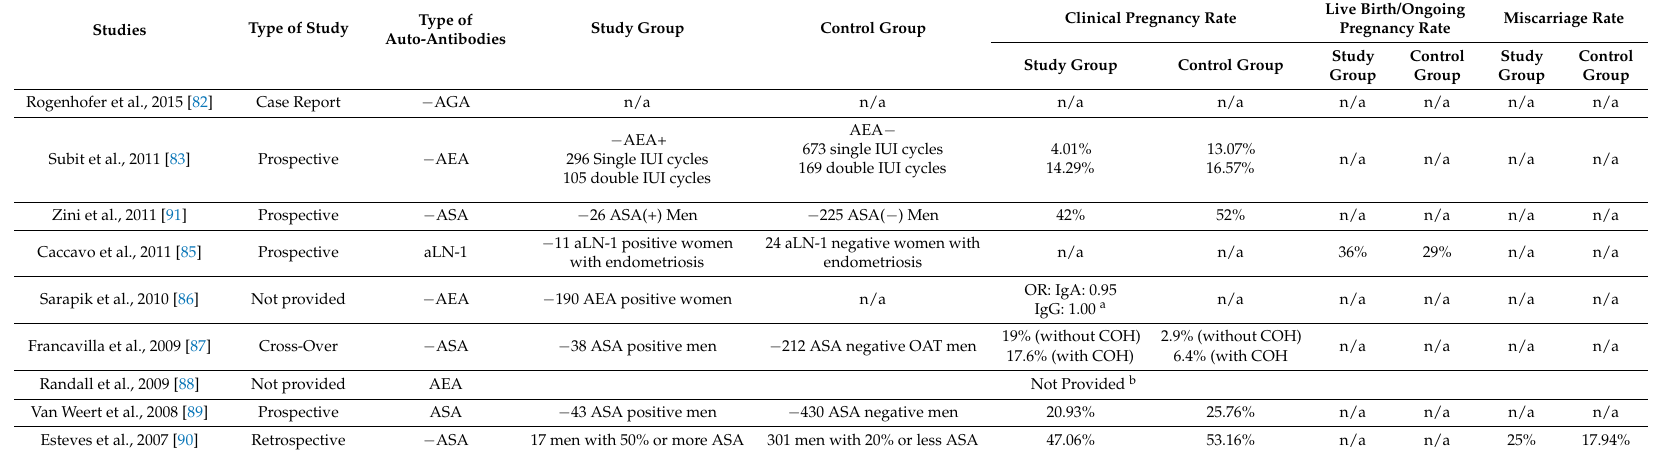
Table 4. Study characteristics regarding auto-antibodies affecting the reproductive